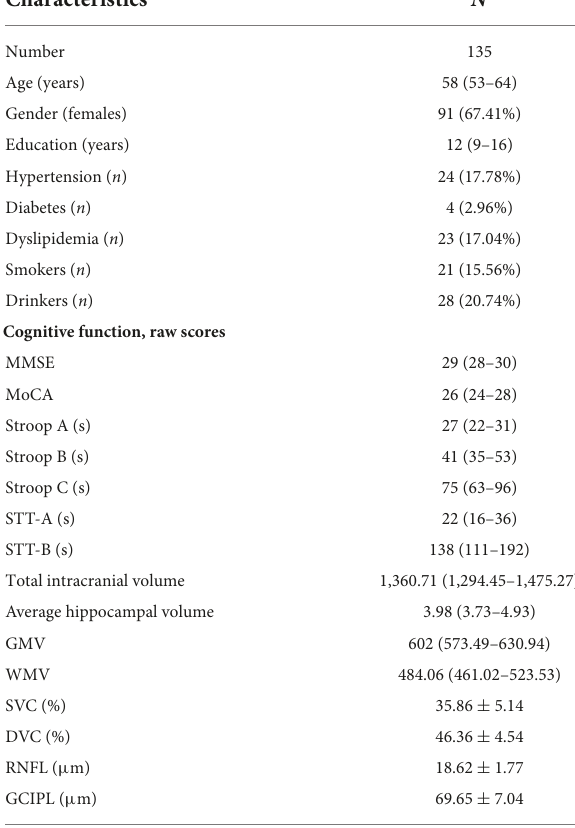
Figure 3 shows the correlation between OCT and OCTA parameters and the association between OCT/OCTA parameters and cognitive measures. Retinal thicknesses TABLE 1 Characteristics of the study